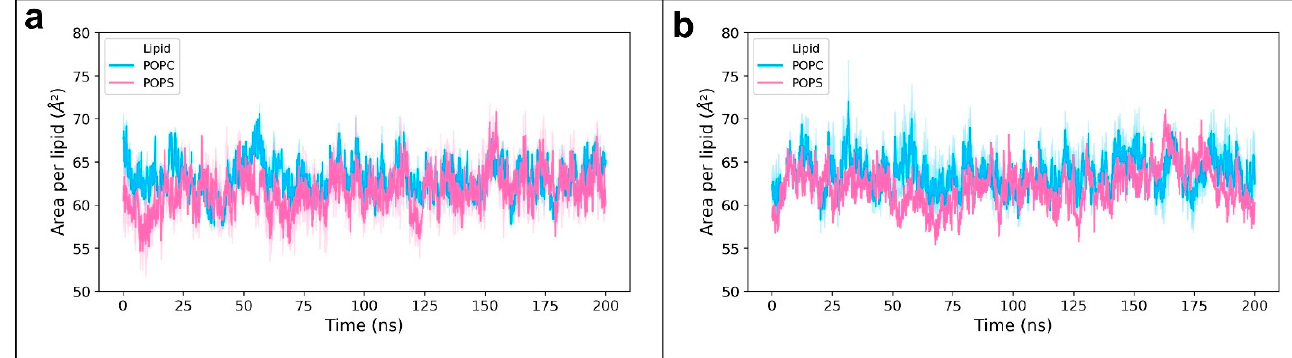
Figure 4. Time-dependent area per lipid values of the membrane models: ( a ) normal membrane and ( b ) cancer membrane. POPC (cyan) and POPS